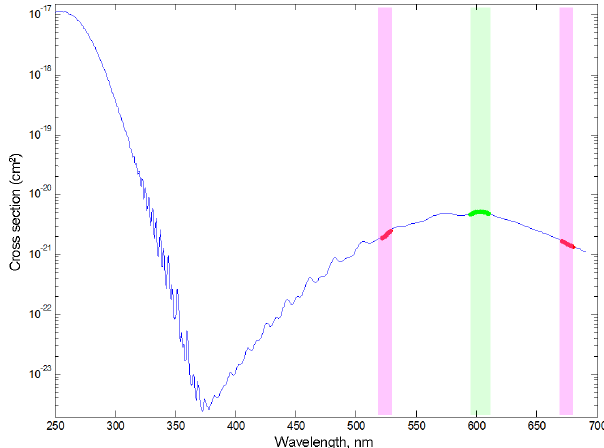
Figure 5. Reference (red, 521–529 and 670–680nm) and absorbing (green, 592–612nm)